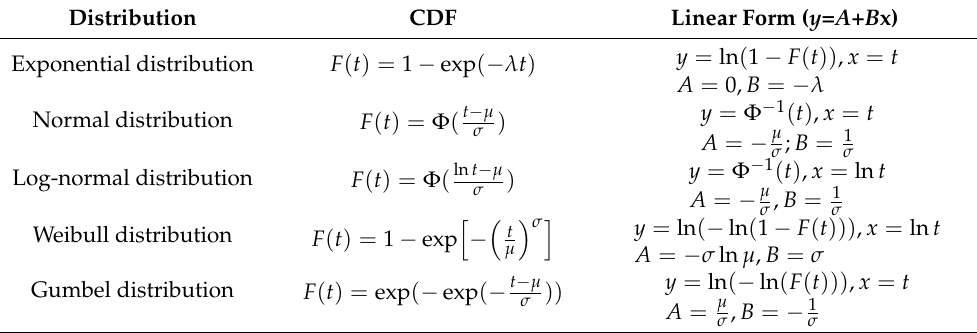
Table 1. The CDF and linear form for each distribution.